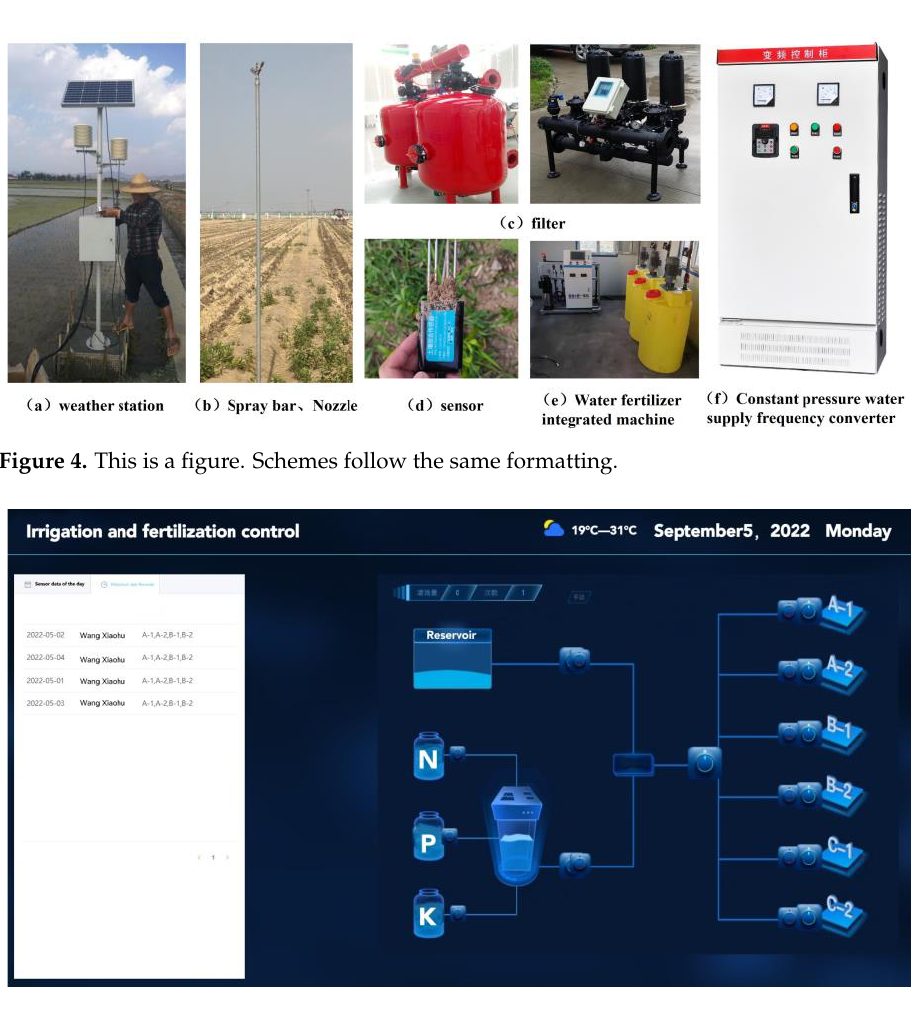
Figure 5. Part of the irrigation monitoring cloud platform interface.